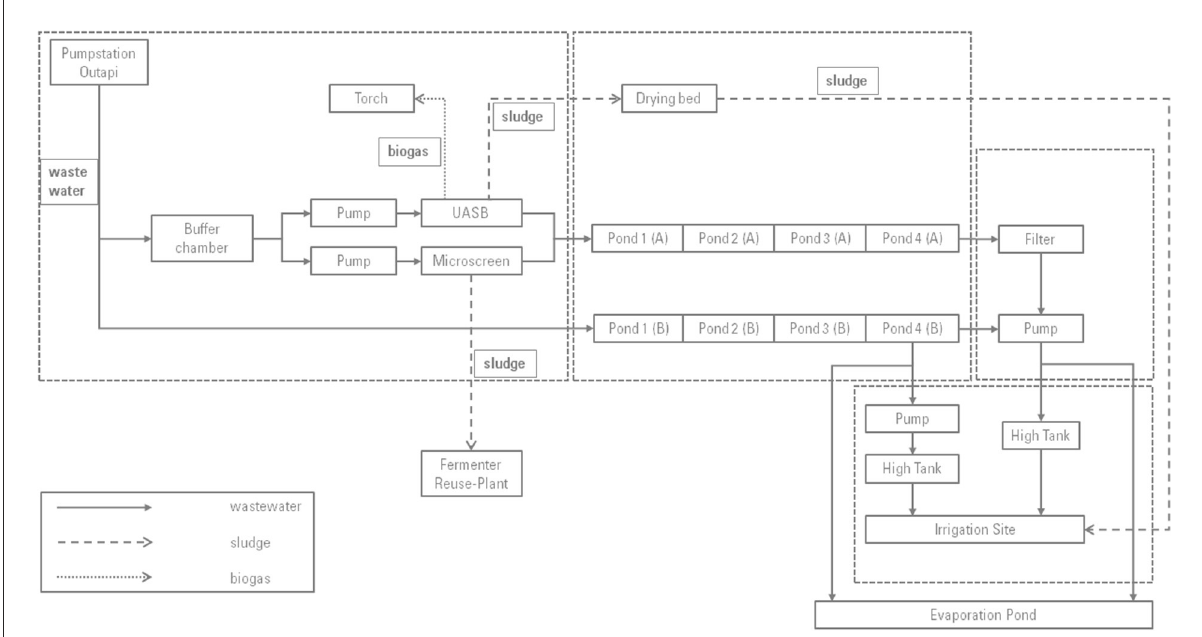
FIGURE1 Flow chart of the improved waste stabilization pond system. Own design based on Sinn et al.